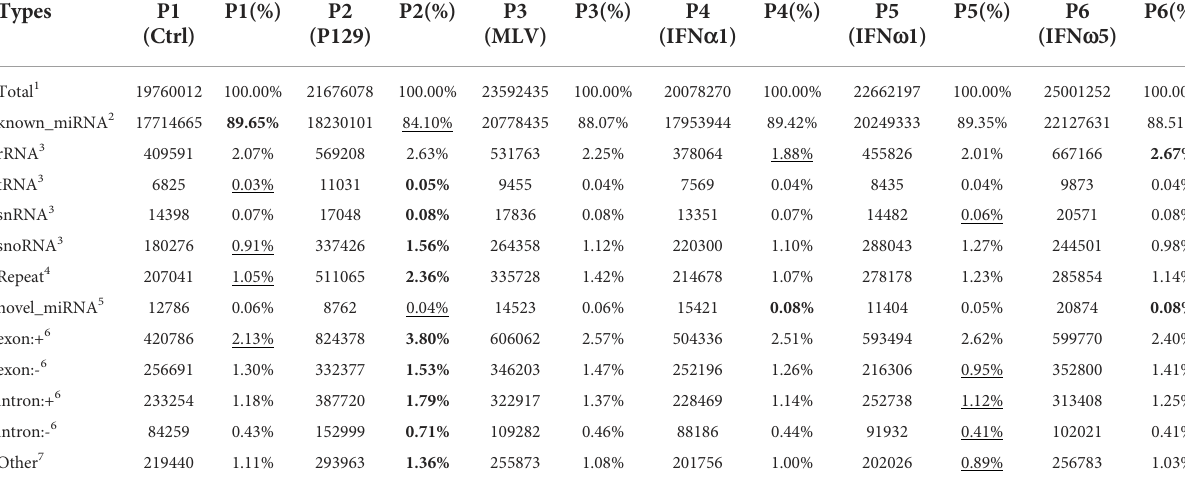
TABLE 2 Summary of small RNA (sRNA)